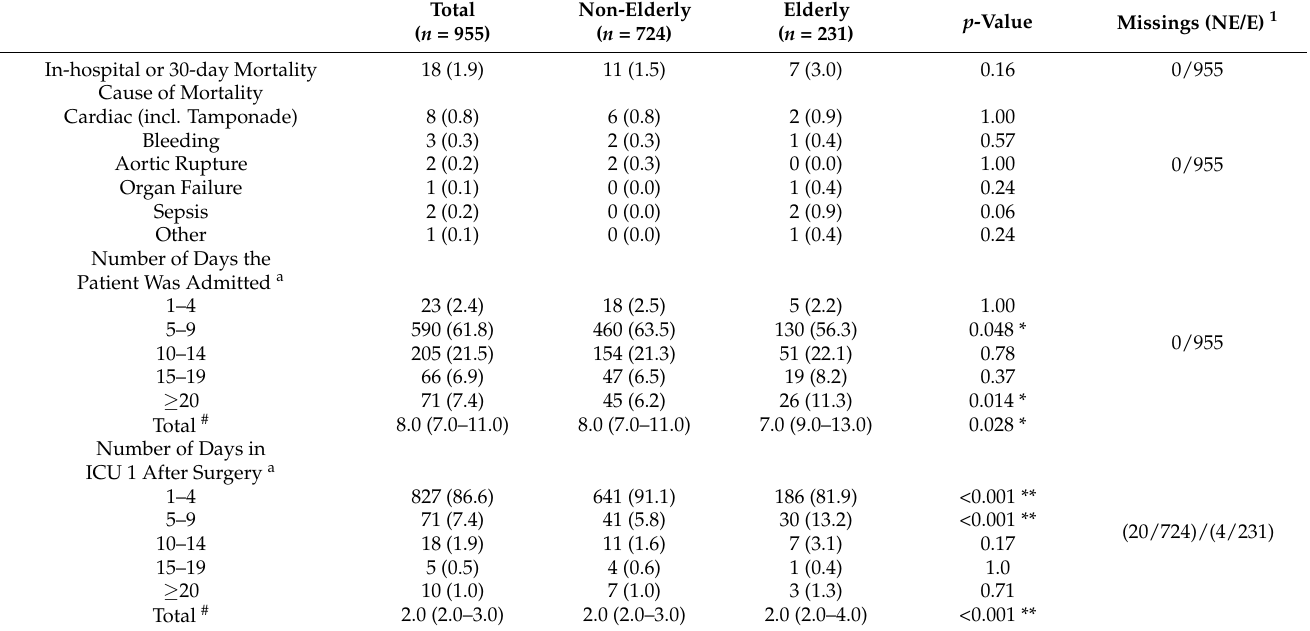
Table 3. Short-term